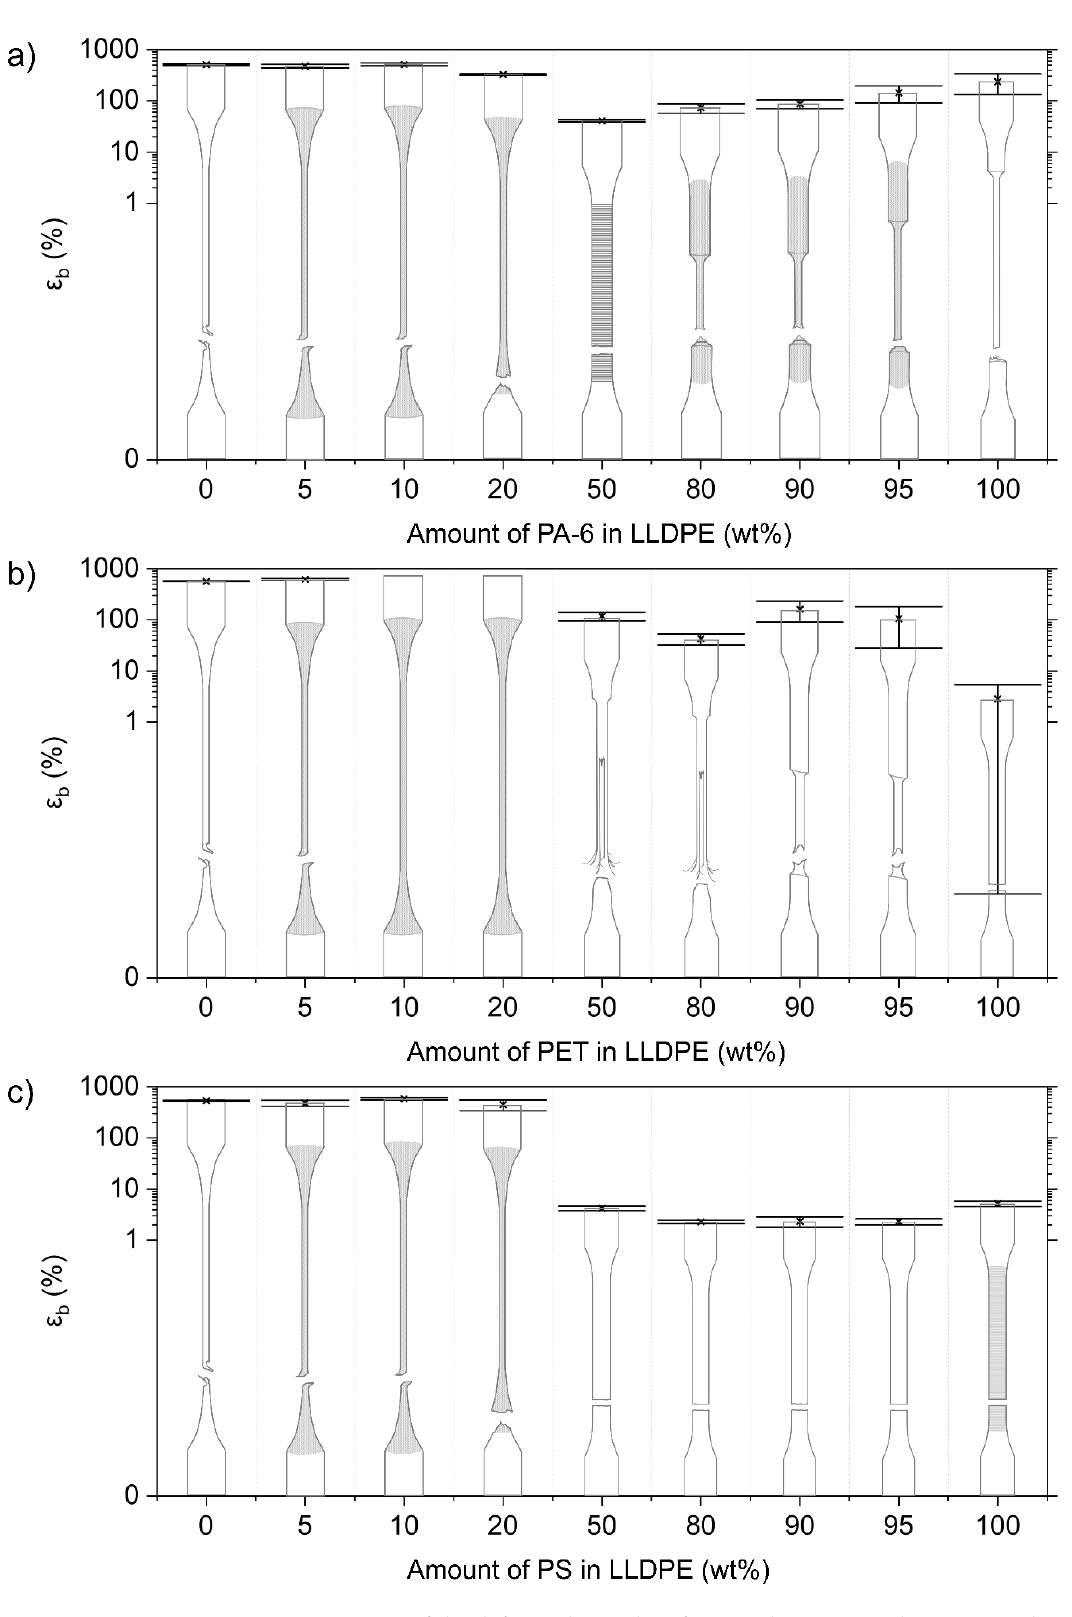
Figure 4. Overview of the deformed samples after tensile testing and respective ε b values for the LLDPE blends combined with ( a ) PA-6, ( b ) PET, and ( c ) PS. Crazing is indicated as fine mark lines for the neat PS. Other shading points to stress whitening, which is visible during/after tensile testing. Coarser markings and lines indicate local points of necking initiation.